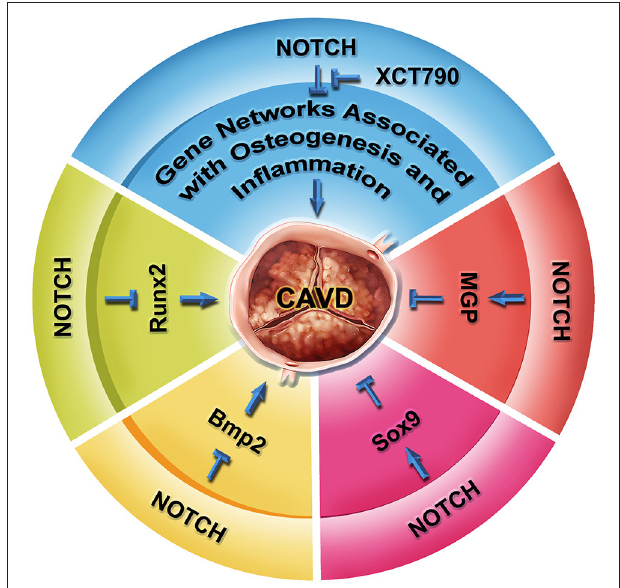
FIGURE 4 | NOTCH signaling in aortic valve homeostasis and CAVD. RUNX2 is a key regulator of osteogenesis, as well as hallmark of CAVD progression. NOTCH represses the transcription of Runx2 mediated by HEY proteins. NOTCH also represses the expression of Bmp2 and BMP2-regulated osteoblast-like calcification pathway. Inhibition of NOTCH leads to calcification via a Sox9 -dependent manner. Conversely, matrix Gla protein MGP suppresses the calcification of soft tissue through antagonizing the BMP signaling. NOTCH positively regulates the transcription of MGP . In human iPSC studies, NOTCH1 haploinsufficiency causes gene network change involved in osteogenesis, inflammation, and oxidative stress through an epigenetic mechanism, which can be reversed by a small molecule XCT790. The XCT790 treatment can slow down calcification in the human iPSCs and a mouse model of